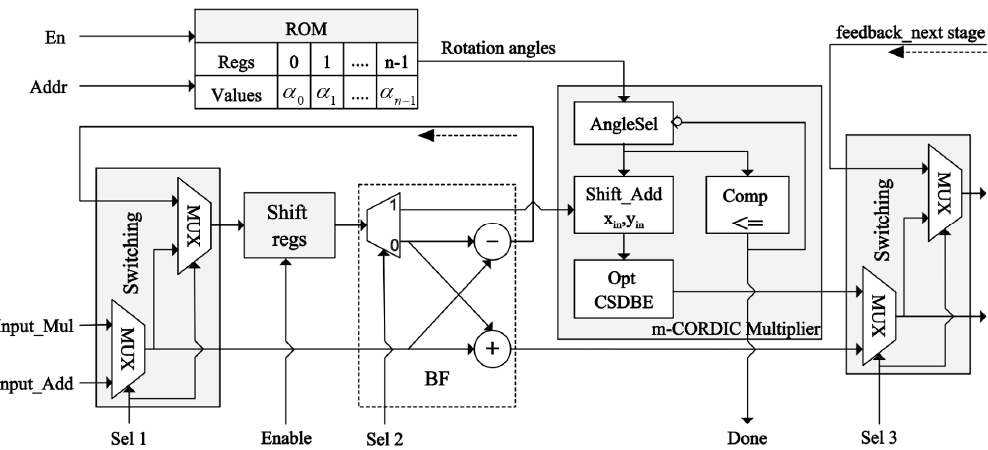
Figure 10. The hardware architecture of a proposed R2FB pipelined stage using m-CORDIC and CSD-based hybrid rotation